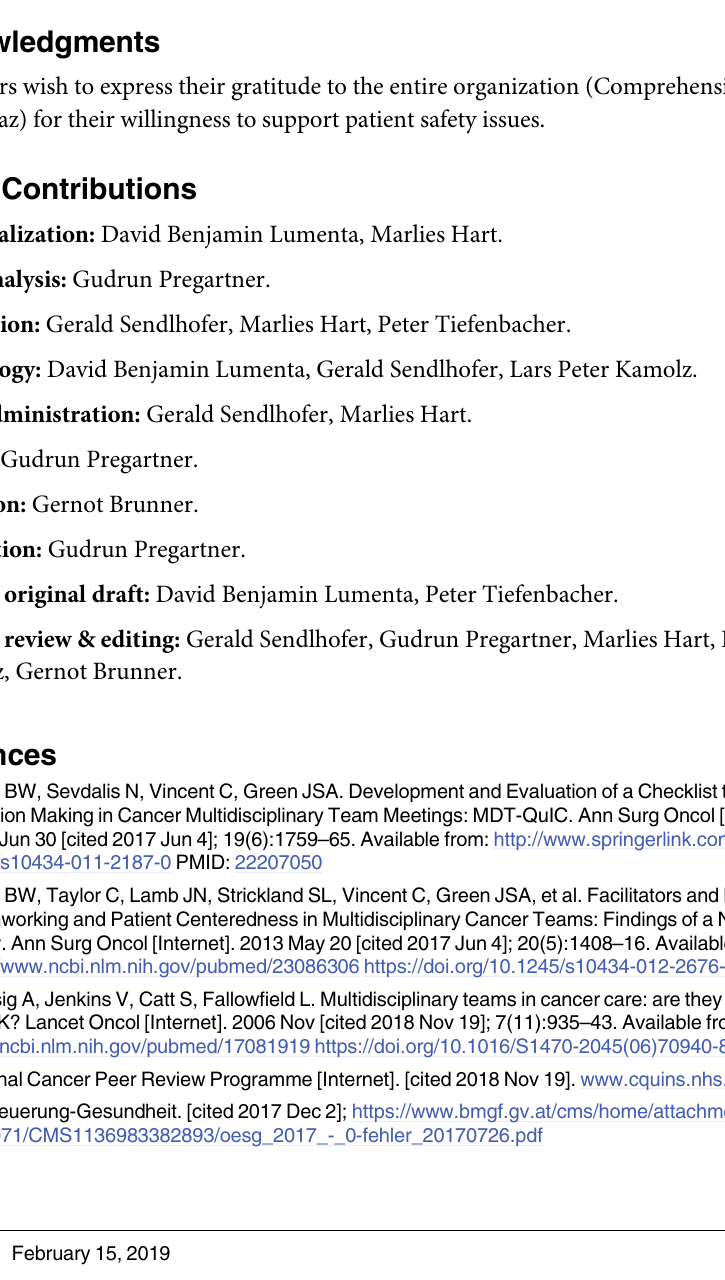
S1 Table. Rate of agreement and Kappa coefficient for complex cases between observers (obs.). S2 Table. Rate of agreement and Kappa coefficient between observers (obs.) for fast track cases. S3 Table. Rate of agreement and Kappa coefficient between observers (obs.) for all